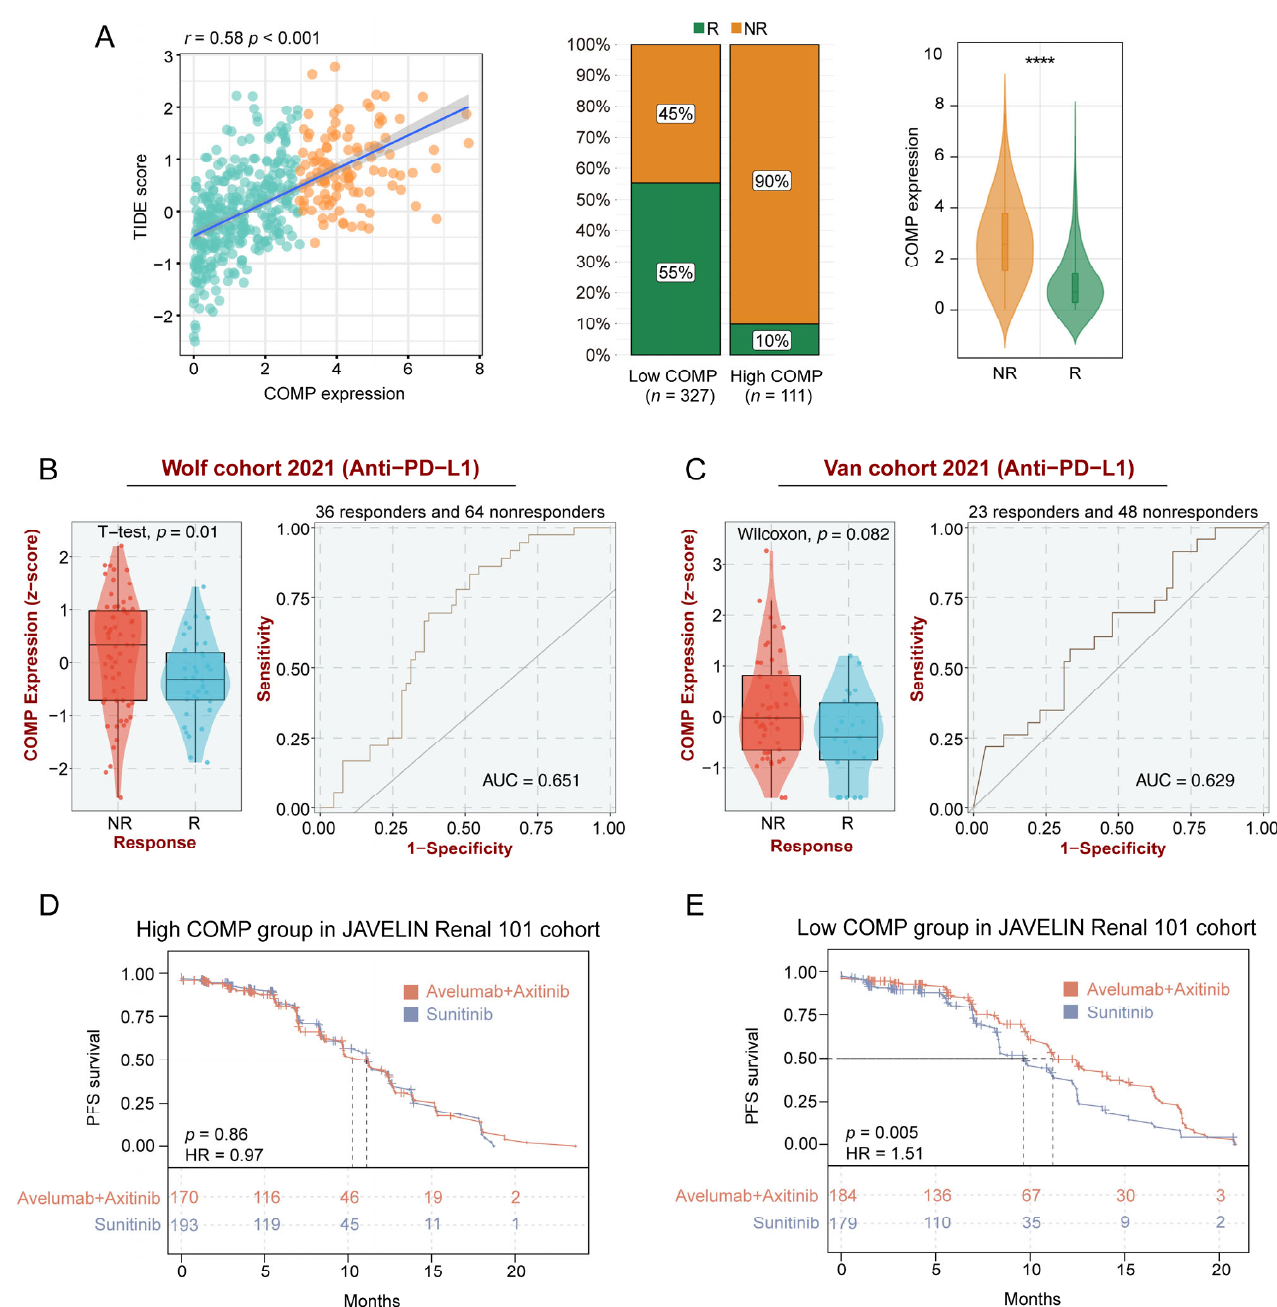
Figure 6. Identification of COMP expression for predicting immunotherapy responses. ( A ) The correlations between COMP expression and the TIDE score, the proportions of patients with putative immunotherapy response in two COMP expression subgroups, and the comparisons of COMP expression between distinct responses in the TCGA cohort. R, responder; NR, nonresponder; ( B,C ) Evaluation of COMP expression in anti-PD-L1 responders versus nonresponders and ROC curves of COMP expression in the Wolf and Van cohorts; ( D,E ) K–M plots for aRCC patients treated with the combination of avelumab and axitinib versus sunitinib alone in high ‐ and low ‐ COMP expression subgroups from the JAVELIN Renal 101 cohort (**** p < 0.0001).